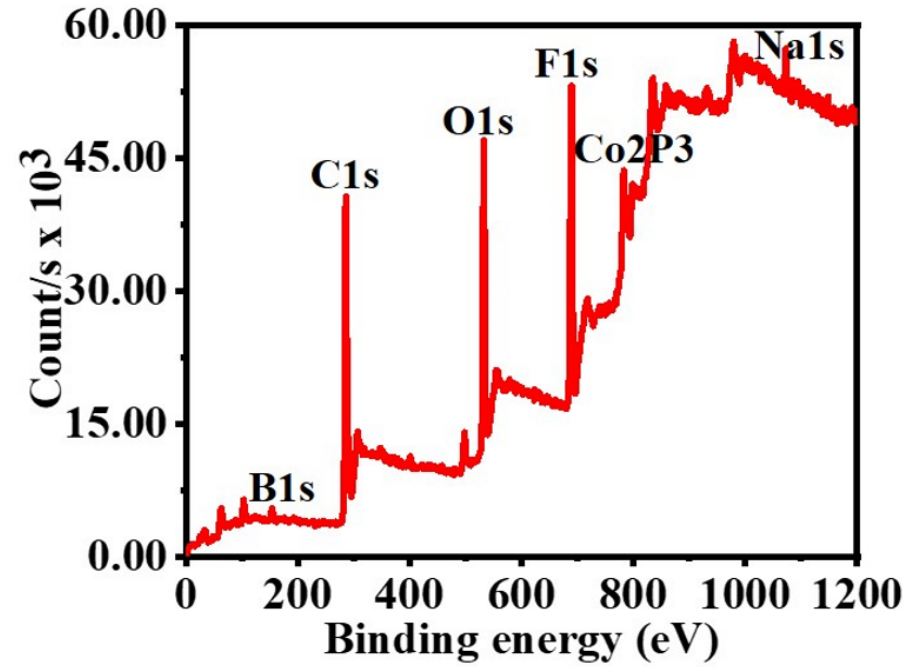
Figure 12. XPS spectrum of PVHF-40 membrane after ten cycles reused.